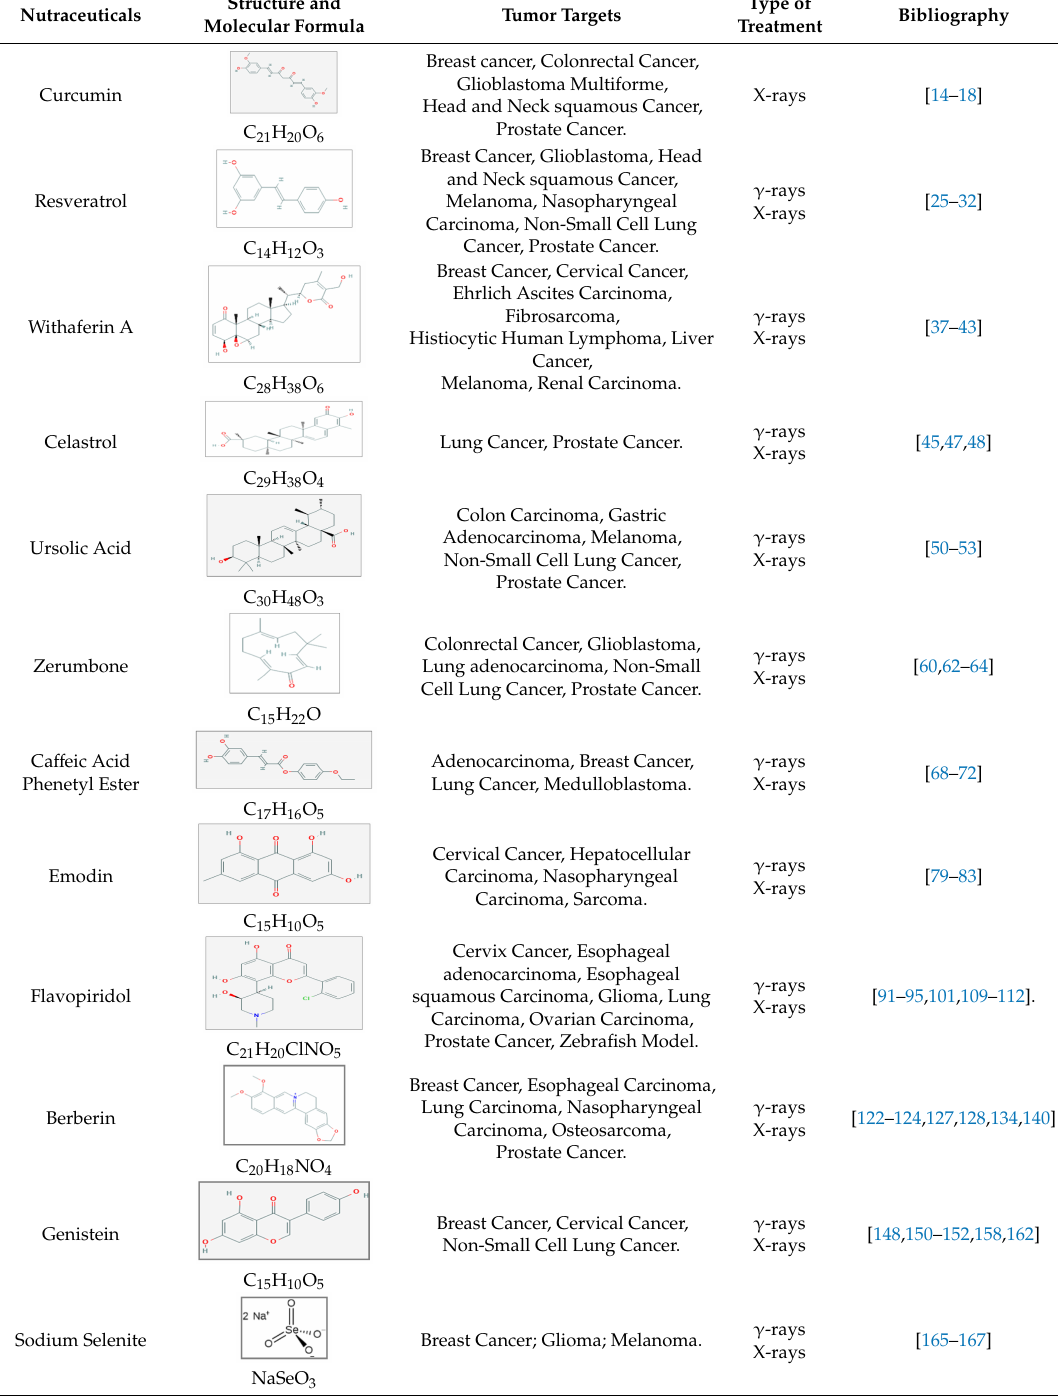
Table 1. The table shows the most relevant and updated works regarding the radiosensitizer e ff ect of the most known natural compounds, cited in this